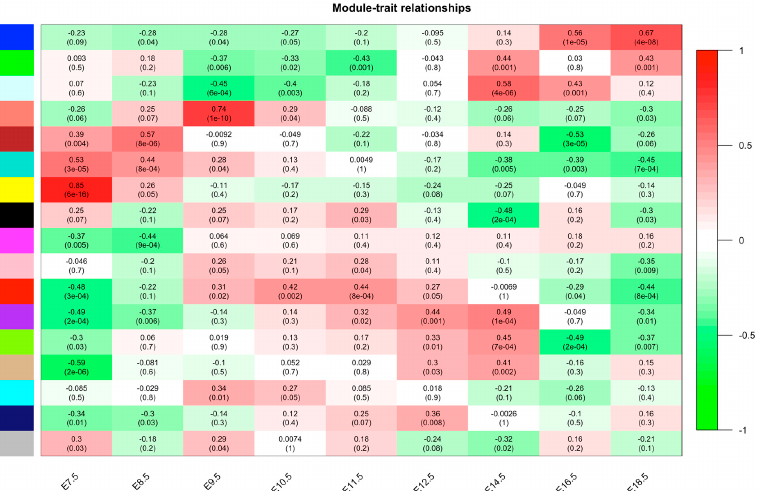
Figure 1. Module–trait relationships. Each row presents a module eigengene, each column presents a clinical trait. Each cell contains the corresponding correlation and p value. The table is color-coded by correlation according to the color legend.